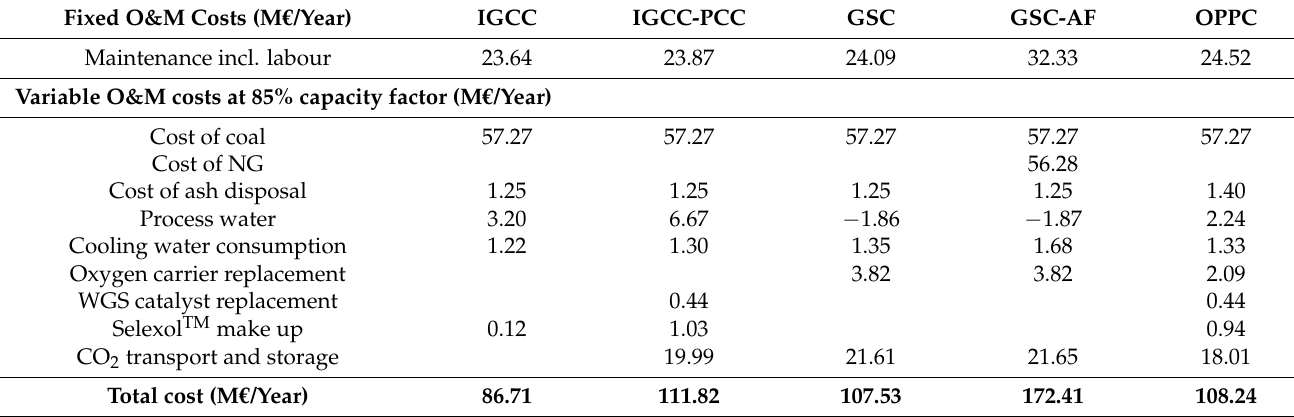
Table 8. O&M costs for the different